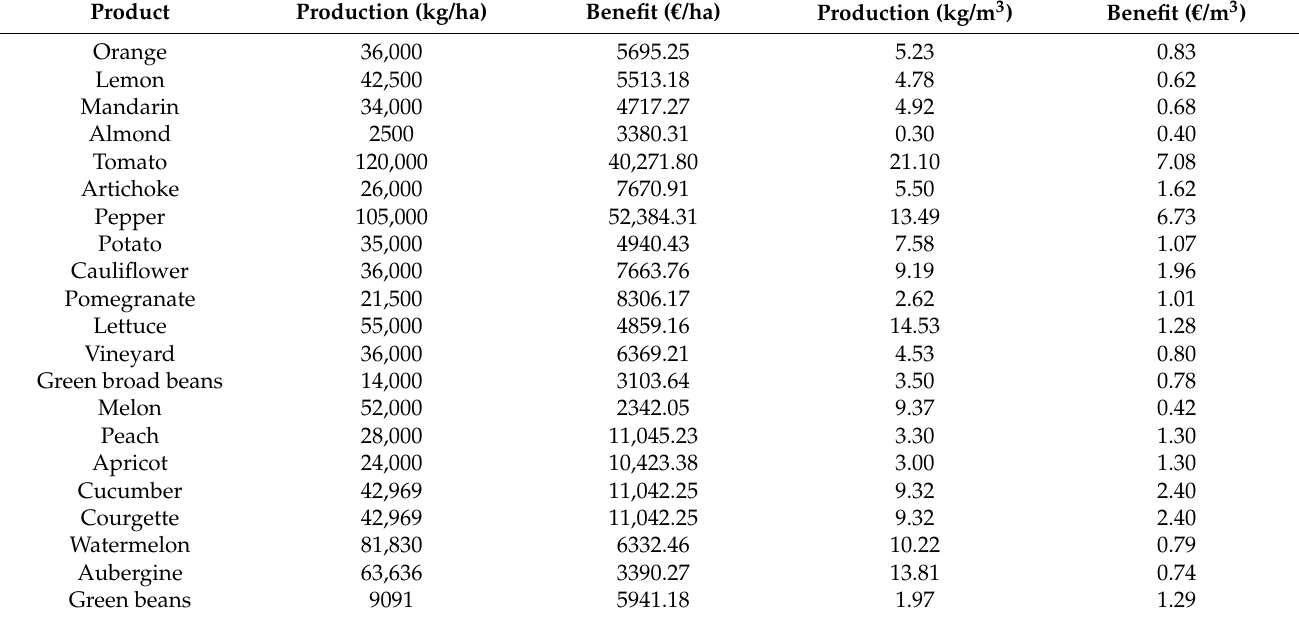
Table 1. Productivity and profit per hectare and cubic metre of water consumed of the main crops in the irrigable areas of the Tagus-Segura water transfer. Source: